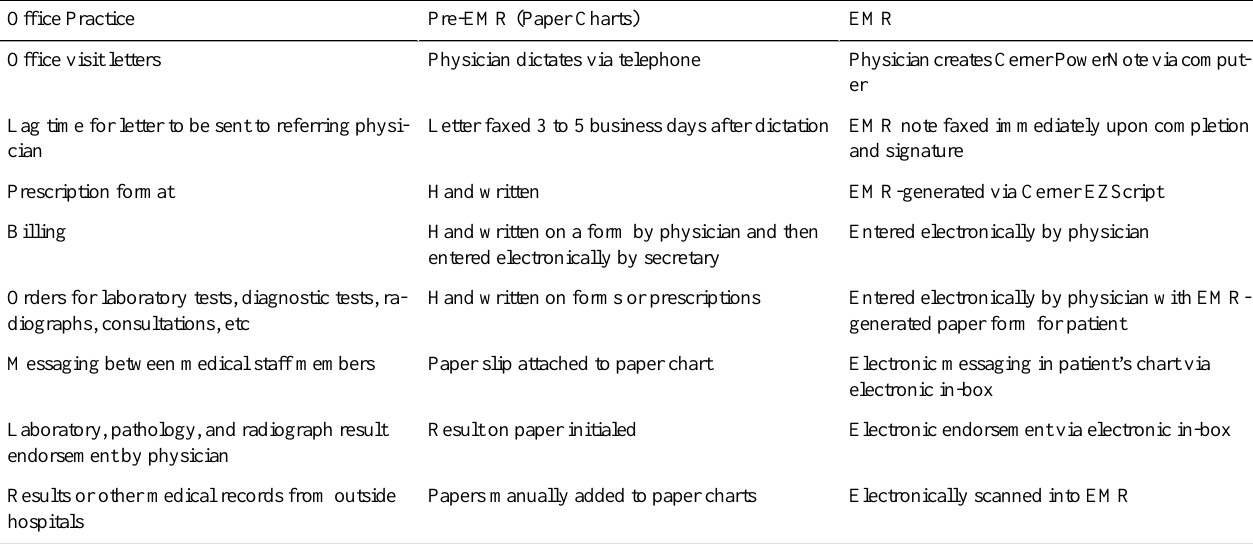
Table 1. Comparison of office practices pre- and post-EMR